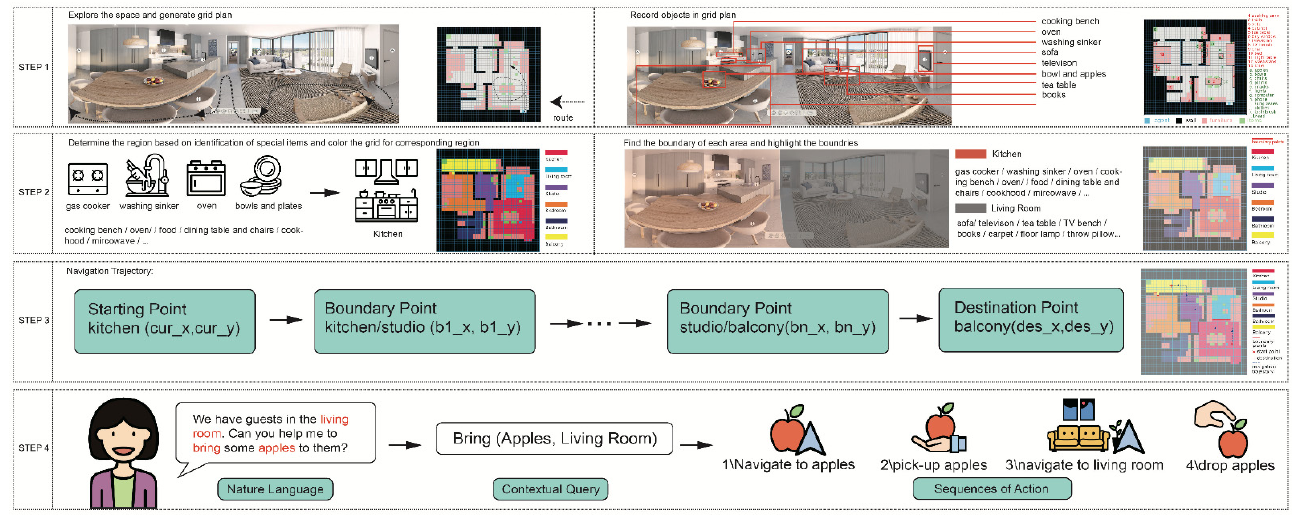
Figure 1. Overview of the ESNI design, step 1: maps floor plans to grid world, step 2: exploration and section segmentation to obtain all information, step 3: use boundary points to generate navigation trajectories, step 4: from NLP to contextual queries to process commands.